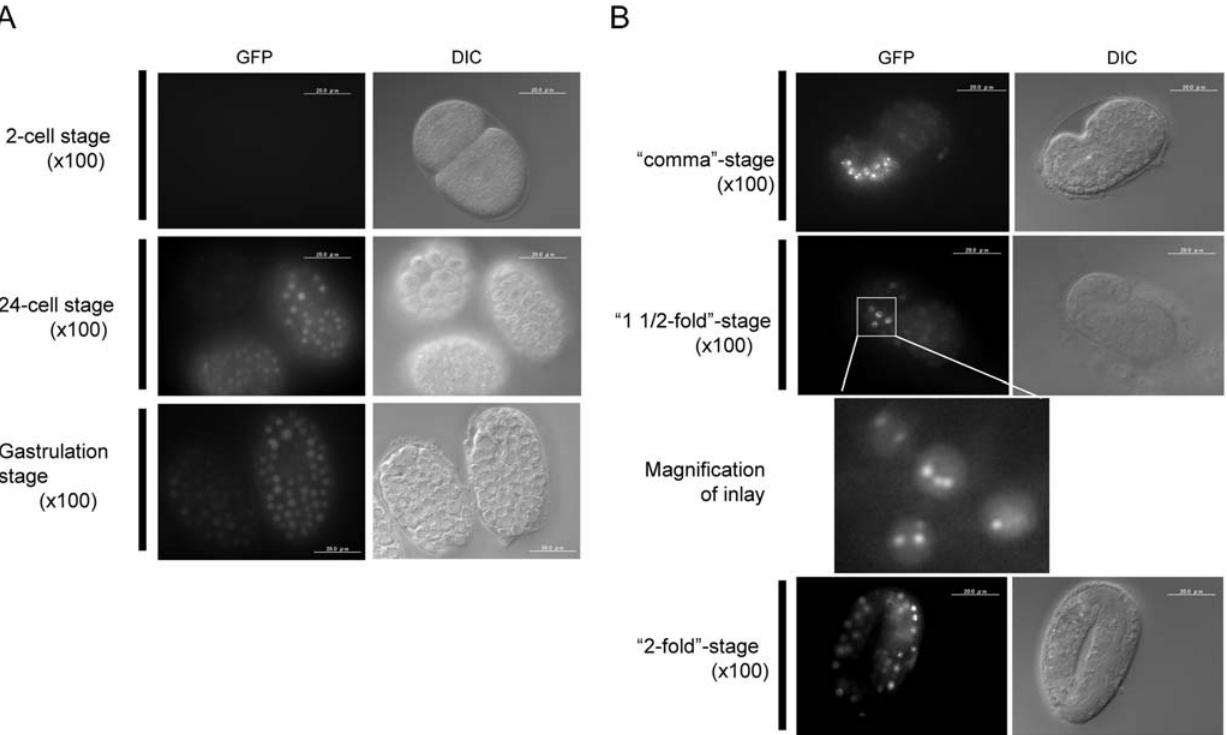
Figure 2. Pqbp-1.1-Venus fusion protein expression during early embryonic stages. A) Expression was detected after 24-cell stage. Pqbp- 1.1-Venus was expressed in all cells until gastrulation stage. The fluorescence negative area corresponds to gastrulation lumen. B) From comma stage, expression of pqbp-1.1-Venus focused to intestine.